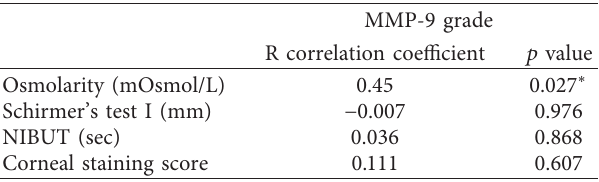
Table 3: Correlation of MMP-9 grade with ocular surface